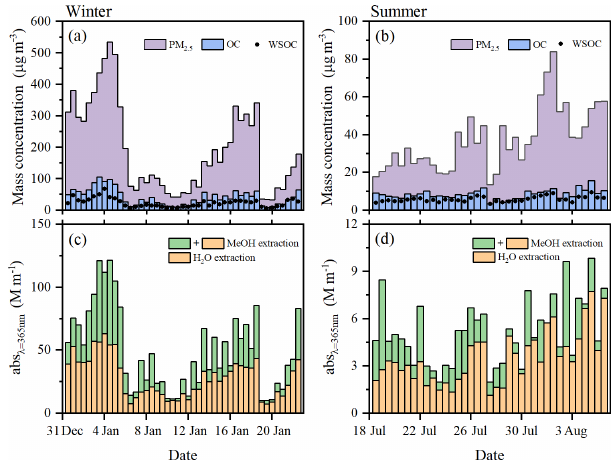
Figure 1. Temporal variations in WSOC, OC, PM 2 . 5 and abs λ = 365nm of PM 2 . 5 samples extracted by water (H 2 O extraction) and methanol (MeOH extraction) during winter (a, c) and summer (b, d) . Table 1. Concentrations of organic carbon in PM 2 . 5 and meteoro- logical conditions during winter and summer of 2017 in Xi’an, in- land China. Winter